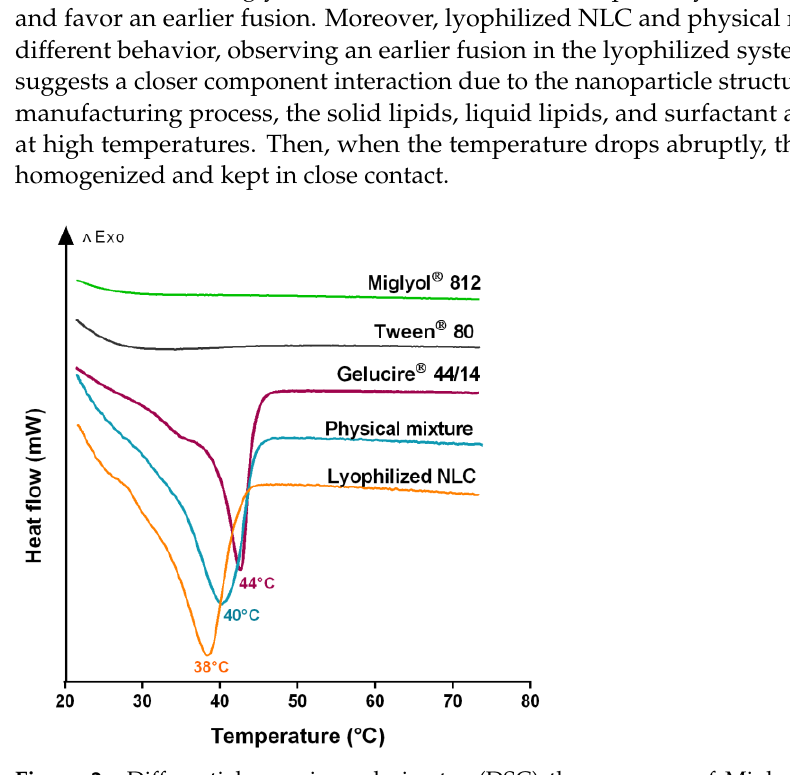
Figure 2. Differential scanning calorimetry (DSC) thermograms of Miglyol ® 812, Tween ® 80, Gelucire ® 44/14, physical mixture of NLC and lyophilized NLC. The figure was produced with a representative profile of repetitions ( n = 1).